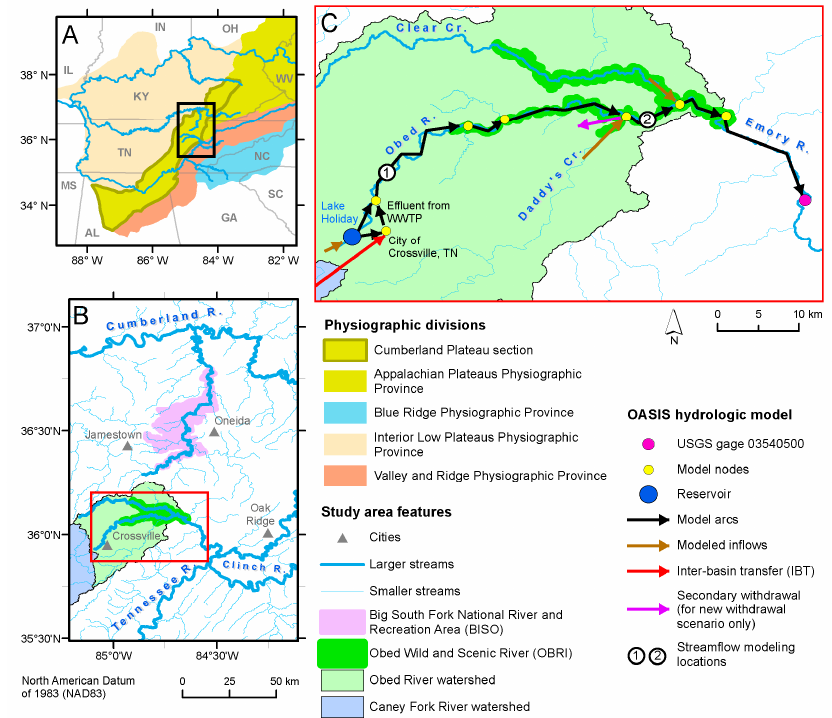
Figure 2. Map location of the case study depicting: ( A ) geographic context of the northern Cumberland Plateau; ( B ) locations of major rivers, protected areas, and cities; and ( C ) components of the OASIS hydrologic model for the Obed River. AL = Alabama, GA = Georgia, IL = Illinois, IN = Indiana, KY = Kentucky, MS = Mississippi, NC = North Carolina, OH = Ohio, SC = South Carolina, TN = Tennessee, WV = West Virginia, Cr = Creek, R = River.